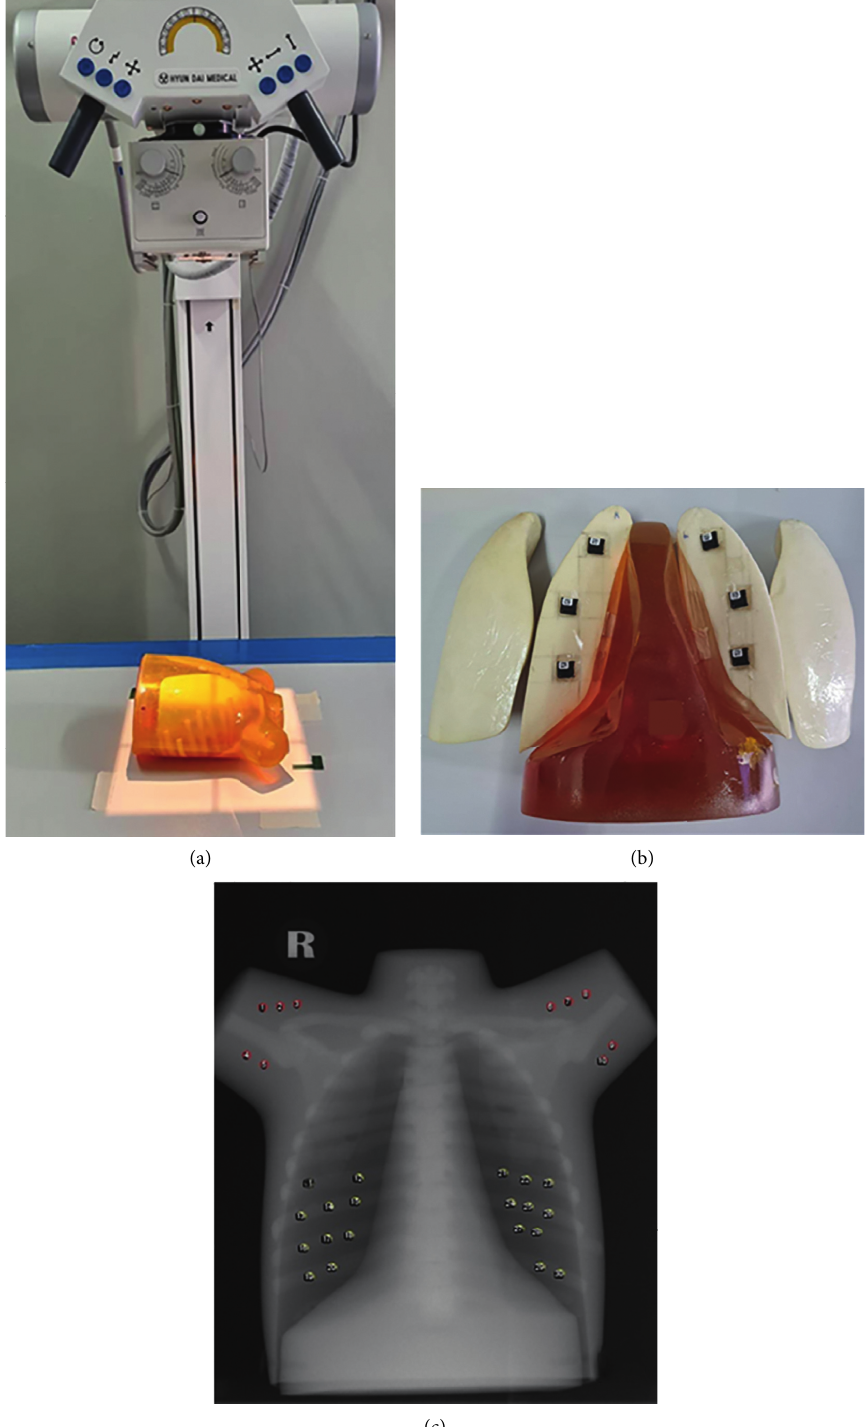
Figure 1: (a) The phantom settings for absorbed dose measurement; (b) the placing location of the nanodots OSLDs in the lung; (c) the location of the ROI measurements on the phantom image using the ImageJ software. The yellow circle and red circle represent the ROI object and ROI background,